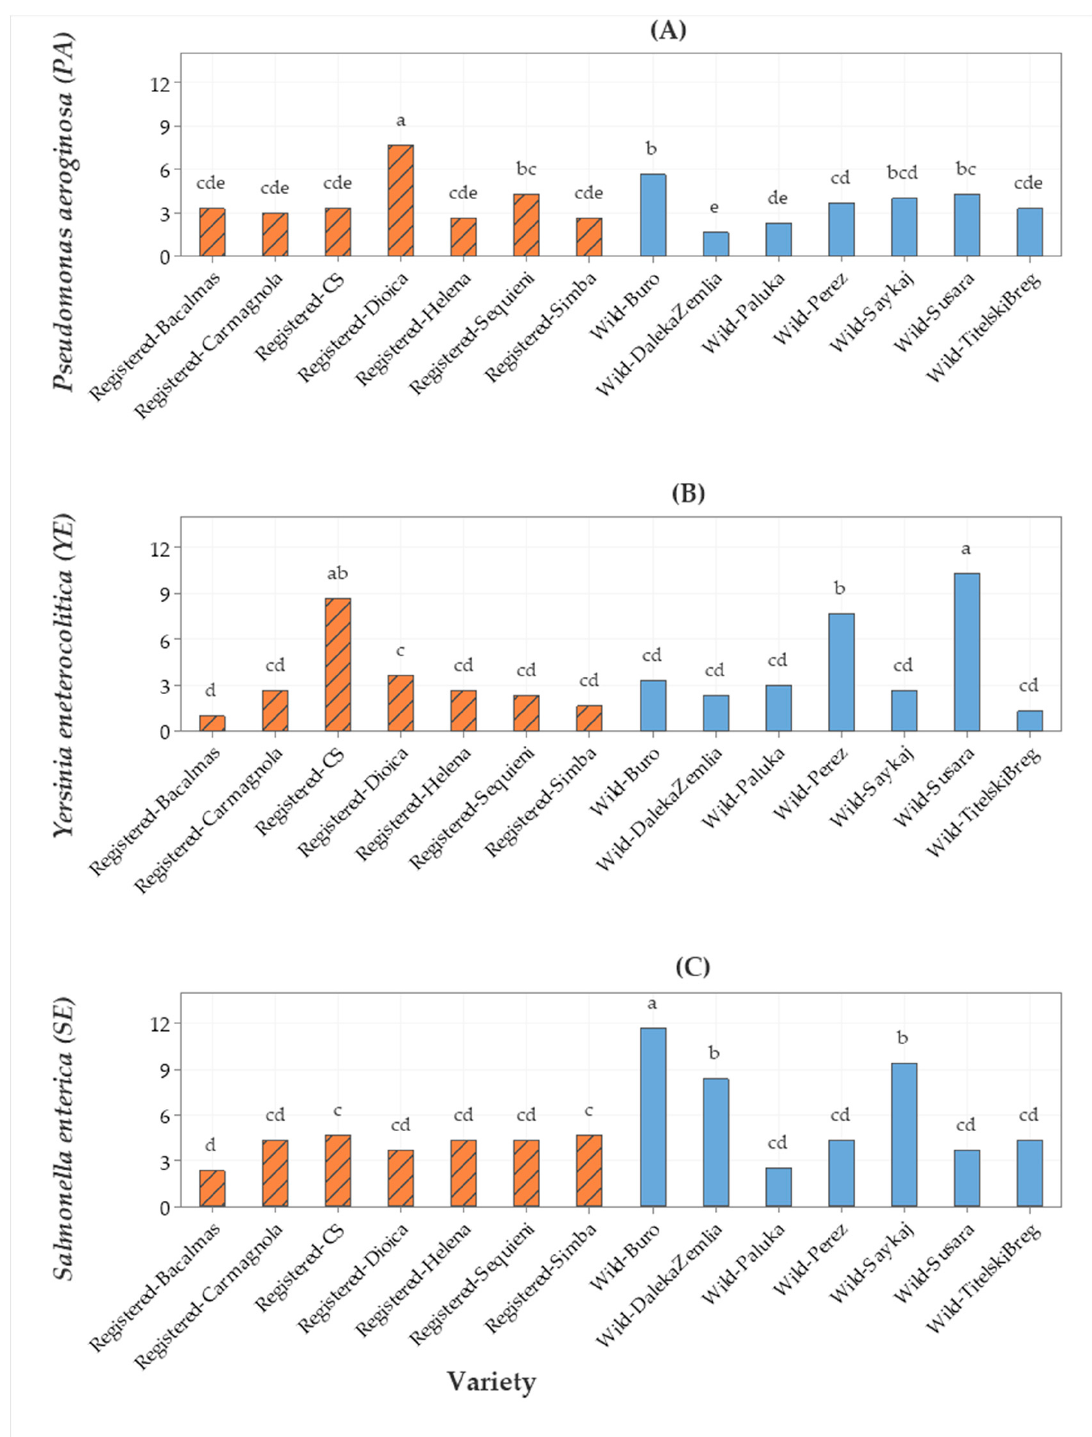
Figure 2 . Bar graph of ( A ) Pseudomonas aeruginosa (PA), ( B ) Yersinia enterocolitica (YE), and ( C ) Salmonella enterica subsp. enterica (SE) (cefoxitin) antimicrobial activities (inhibition zone in mm) from seven registered cultivars and seven wild accessions. The means represented by the bars sharing the same letter are not significantly different.